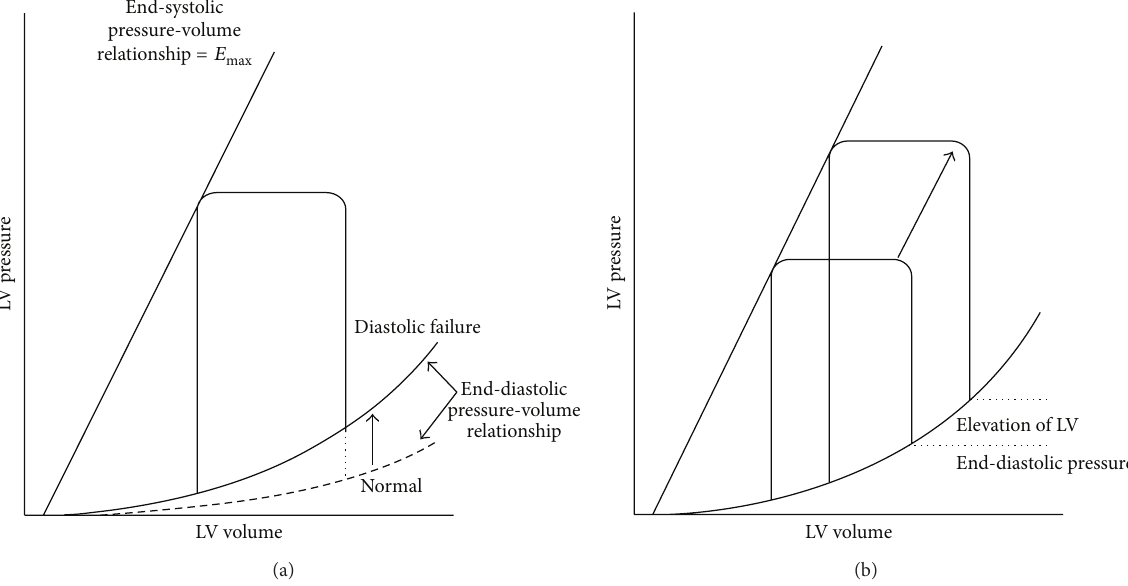
Figure 1: (a) The end-systolic pressure-volume relationship is the same as a normal heart in diastolic heart failure, but the end-diastolic pressure-volume relationship shifts upwards. As a result, left ventricular end-diastolic pressure rises. (b) In pathologies with diastolic dysfunction, when an abrupt increase in blood pressure occurs, the pressure-volume loop shifts to the upper right without decrease in 𝐸 max . Therefore, pulmonary congestion is induced as a result of the significant increase in left ventricular end-diastolic pressure. LV: left